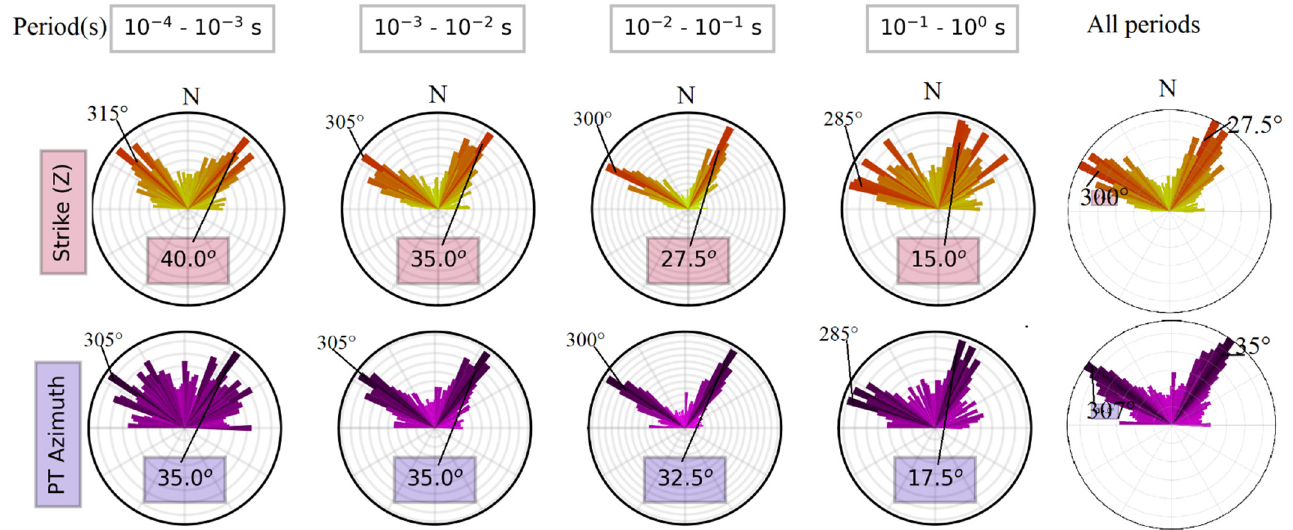
Figure 8. Multi-period rose diagrams of geoelectric strikes estimation at decade and at all periods from invariants of impedance tensor (Z) [73] and phase tensor (PT) [66]. North (N) is assumed to be 0 and the strike angle is measured clockwise positive.